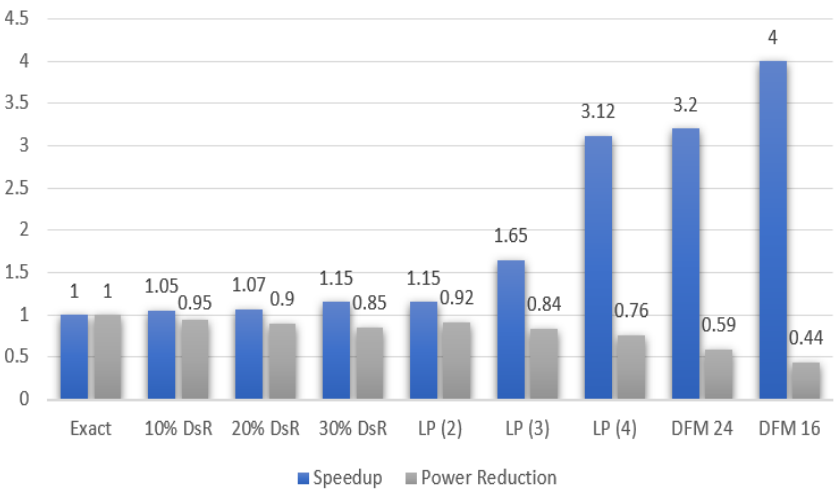
Figure 8. Speedup and power consumption reduction under different